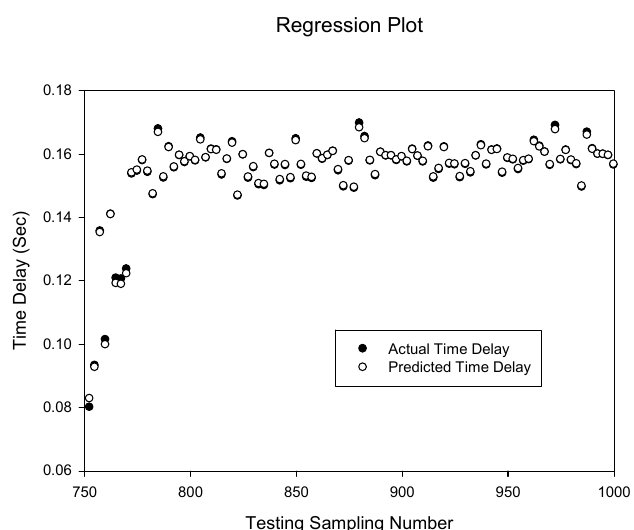
Testing Sampling